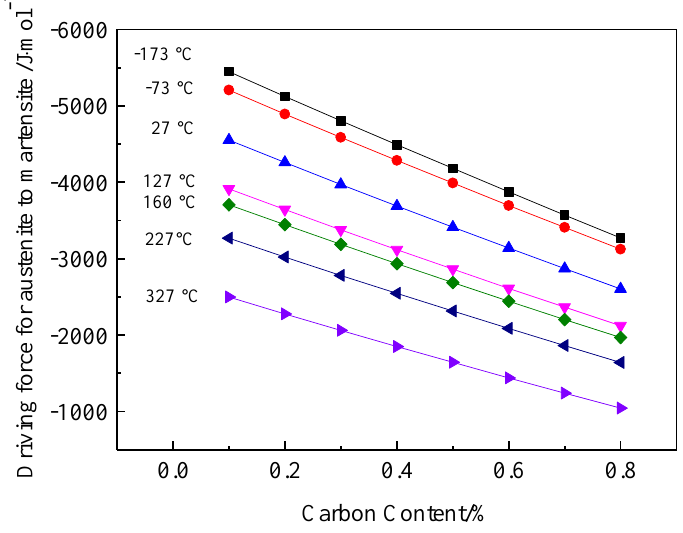
Figure 11. Driving force for the phase transformation of austenite into martensite.